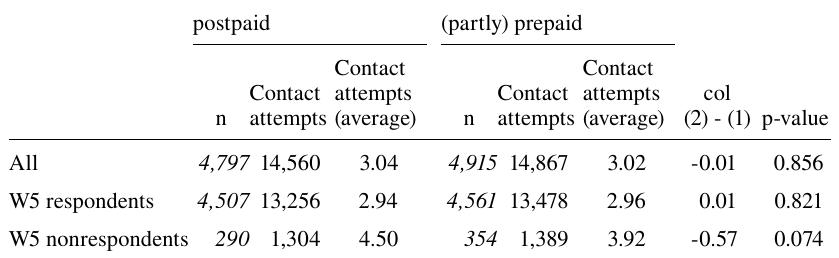
Contact col Contact attempts (2) - (1) p-value n attempts (average)